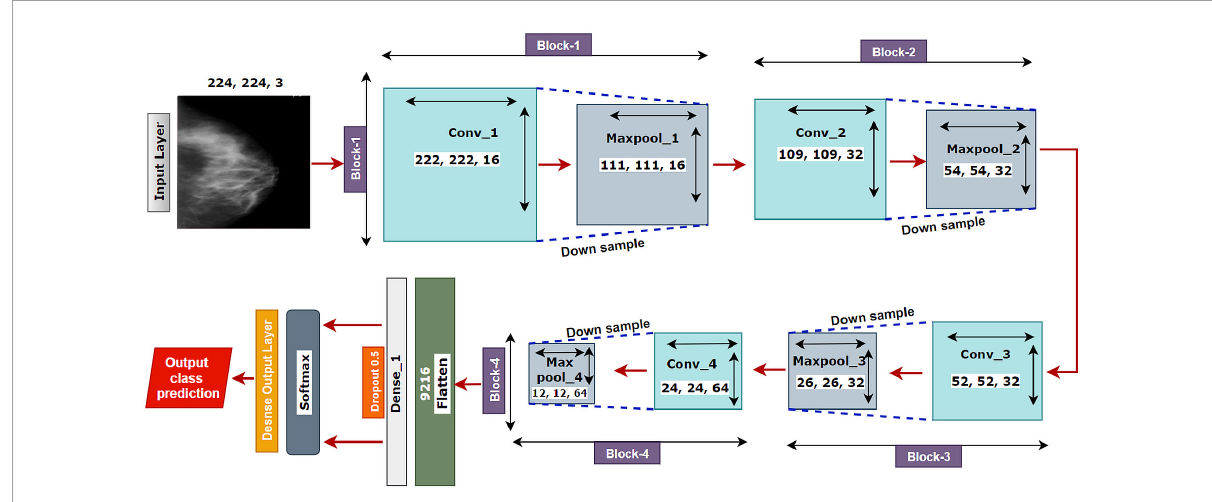
FIGURE6 The architecture of the proposed MNet-10 model after ablation